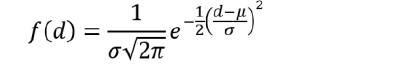
Fig. 7. The captured image for shutter speed 3  s: a) 1000 W Halogen lamp; b) 72 W LED bar panel; c) 60 W LED chip; d) 90 W LED chip.